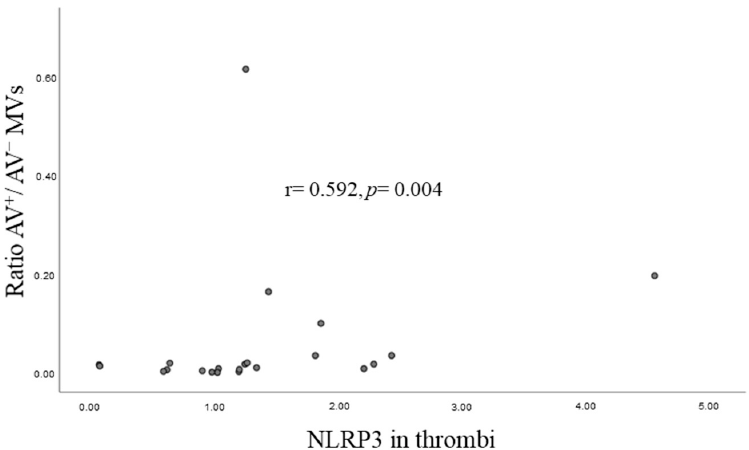
Figure 2. Neutrophil ( A – C )- and endothelial ( D )-derived MVs and the IL-6 signalling pathway.